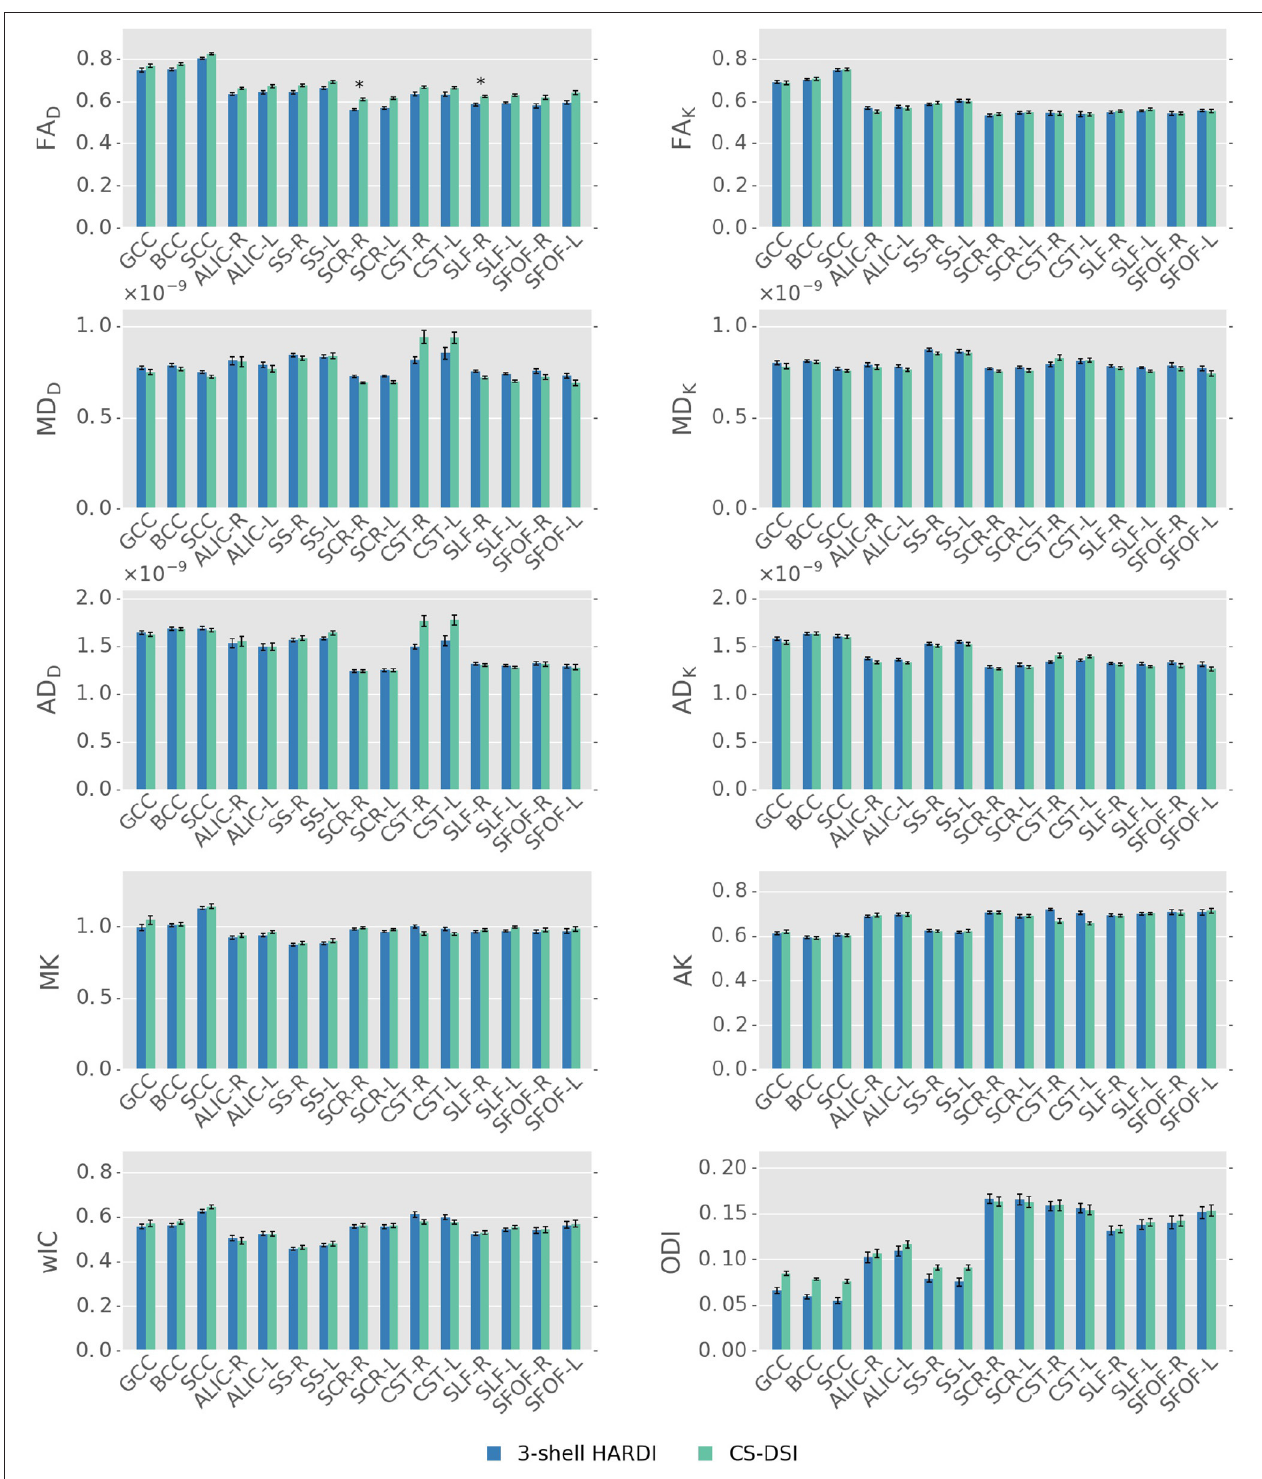
FIGURE 5 | Parameter specific group mean and standard error for the tensor (FA D , MD D , AD D ), kurtosis (FA K , MD K , AD K , MK, AK), and NODDI (wIC, ODI) model. For each WM ROI, mean p -values were extracted from the respective skeleton and are, if significant ( p < 0.025), indicated as: * p < 0.025 and ** p < 0.005. Except for FA derived from the tensor model, the analysis of significant differences in diffusion parameters estimated from CS-DSI and 3-shell HARDI acquisitions indicates comparable performance of both schemes. Diffusivities are given in units of m 2 /s.